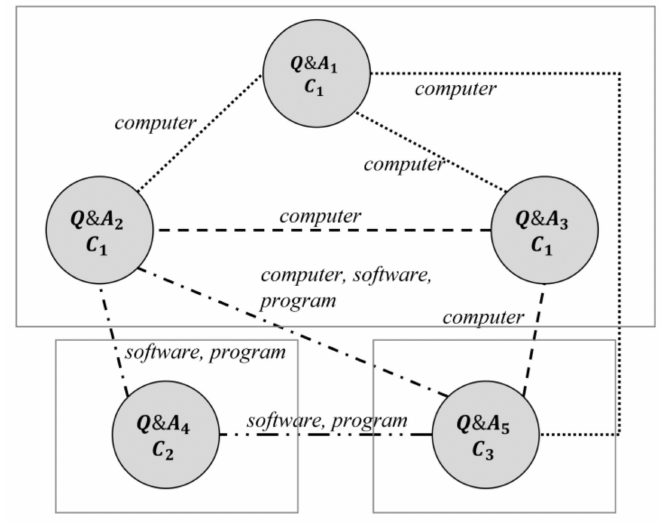
Figure 4. Example of Q&A relevance graph.